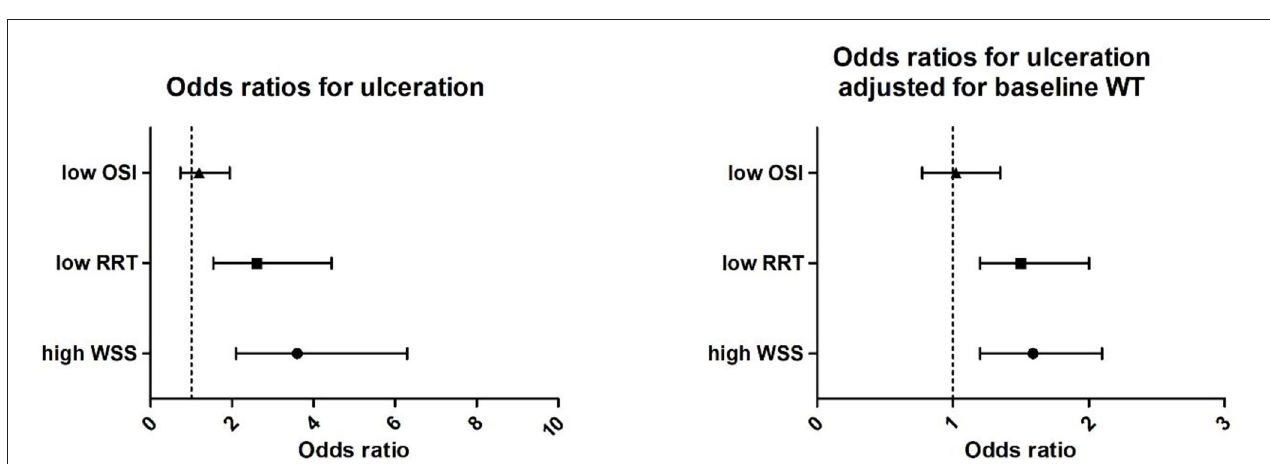
FIGURE 5 | (Left) Univariate correlation of high wall shear stress (WSS, > 4.2Pa), low relative residence time (RRT, < 0.25 Pa − 1 ), and oscillatory shear index (OSI < 0.0006) with ulceration presented as odds ratios and (right) odd ratios adjusted for baseline wall thickness.